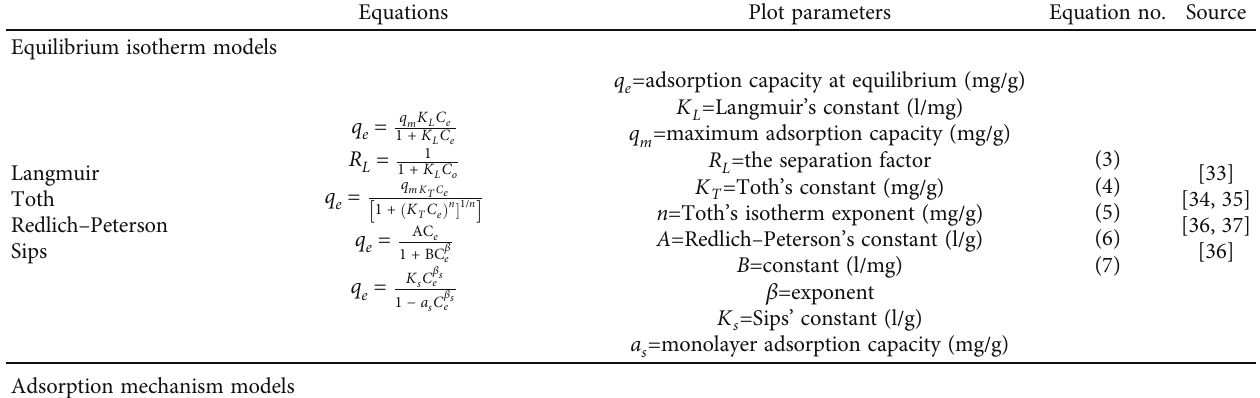
Table 1: Equations of the isotherm models, mechanism models, thermodynamics, isosteric heat of adsorption, and error functions [33 – 43]. Equations Plot parameters Equation no.